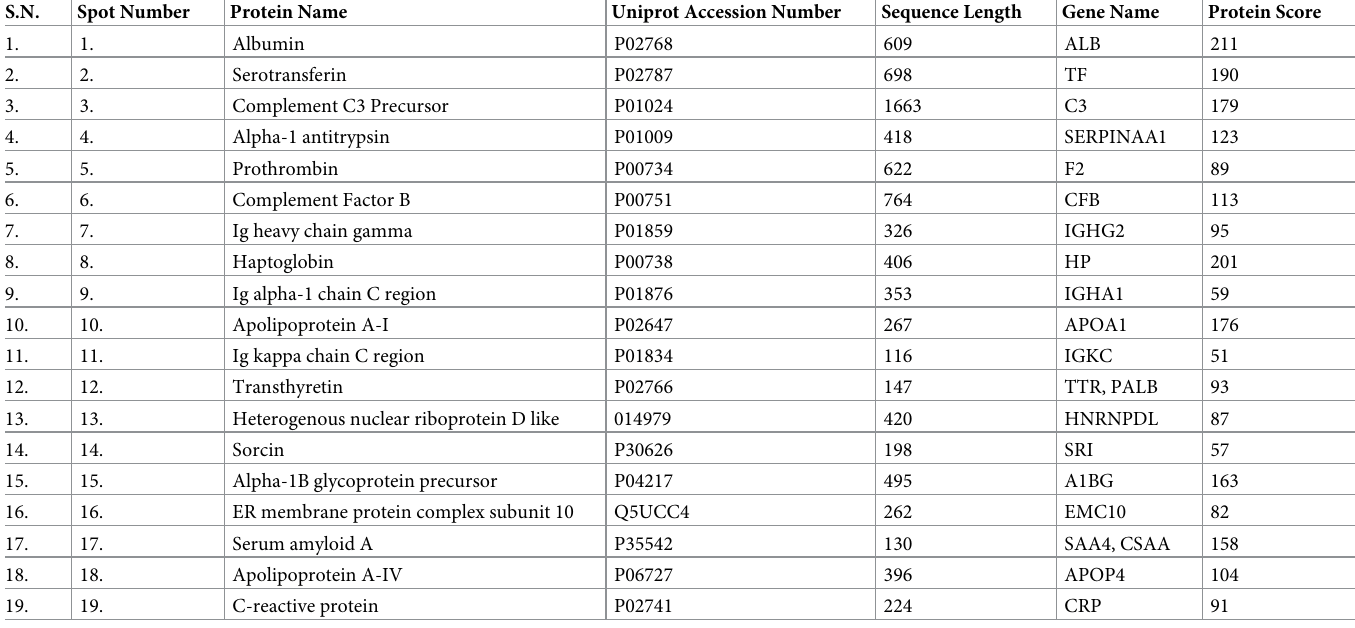
Table 4. MALDI-TOF/ MS analysis of differentially expressed serum protein normal and LF cases.